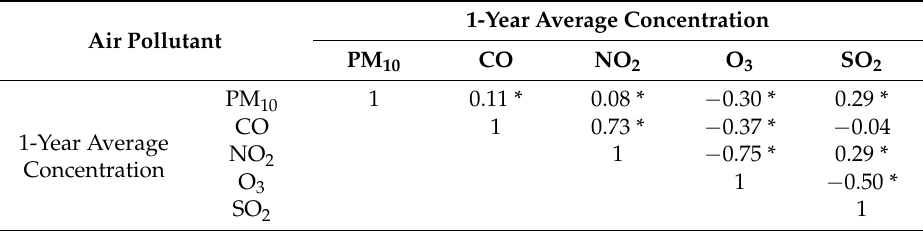
Table 3. Spearman correlation coefficients for the estimates of air pollutant concentrations.